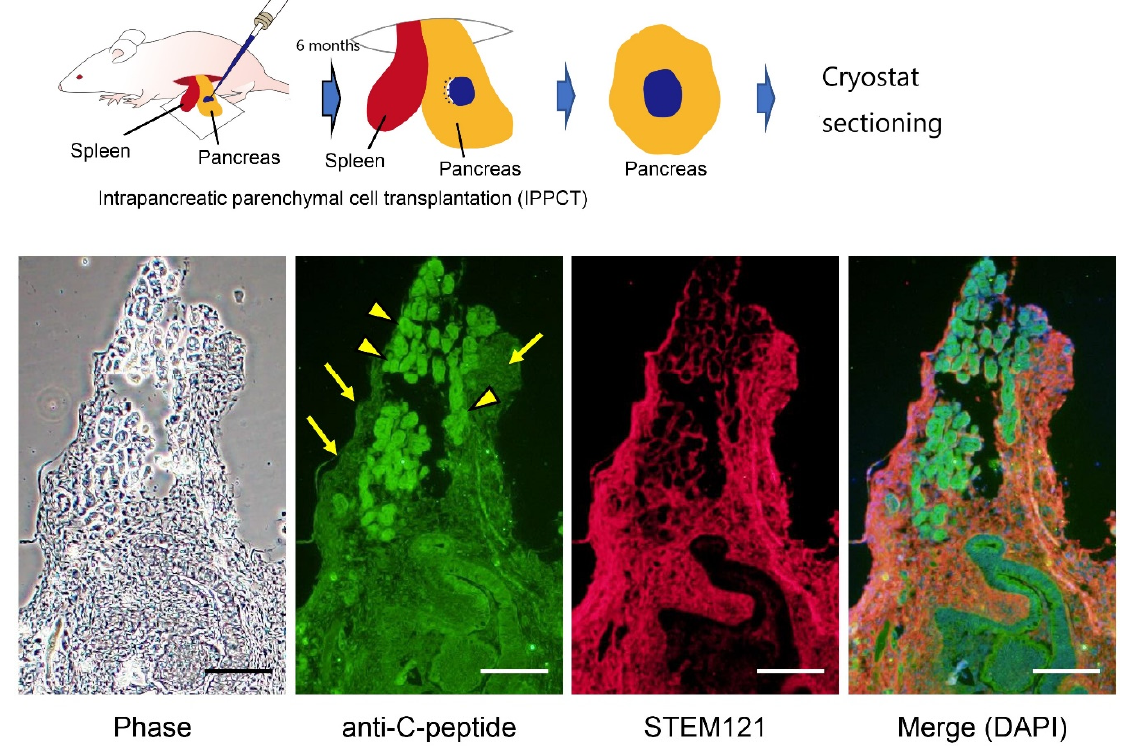
Figure 5. Production of insulin in the grafts after intrapancreatic parenchymal cell transplantation in nude mice. In vitro cultured cell masses (on day 15 after induction; see Figure 4) derived from HDDPC-NSCs were transplanted into the pancreas of nude mice under a dissecting microscope using a glass micropipette (shown above). Six months after grafting, the pancreas was dissected and subjected to cryostat sectioning. Immunostaining using antibodies against insulin (C- peptide) revealed the presence of insulin-positive cells (arrowed) in the graft. Immunostaining using antibodies against STEM121, human cell-specific antibodies, revealed the presence of HDDPC-NSC-derived cells. Arrowheads indicate mouse pancreatic islets. We obtained these images from experiments performed exclusively for this review. Scale = 100 μ m.